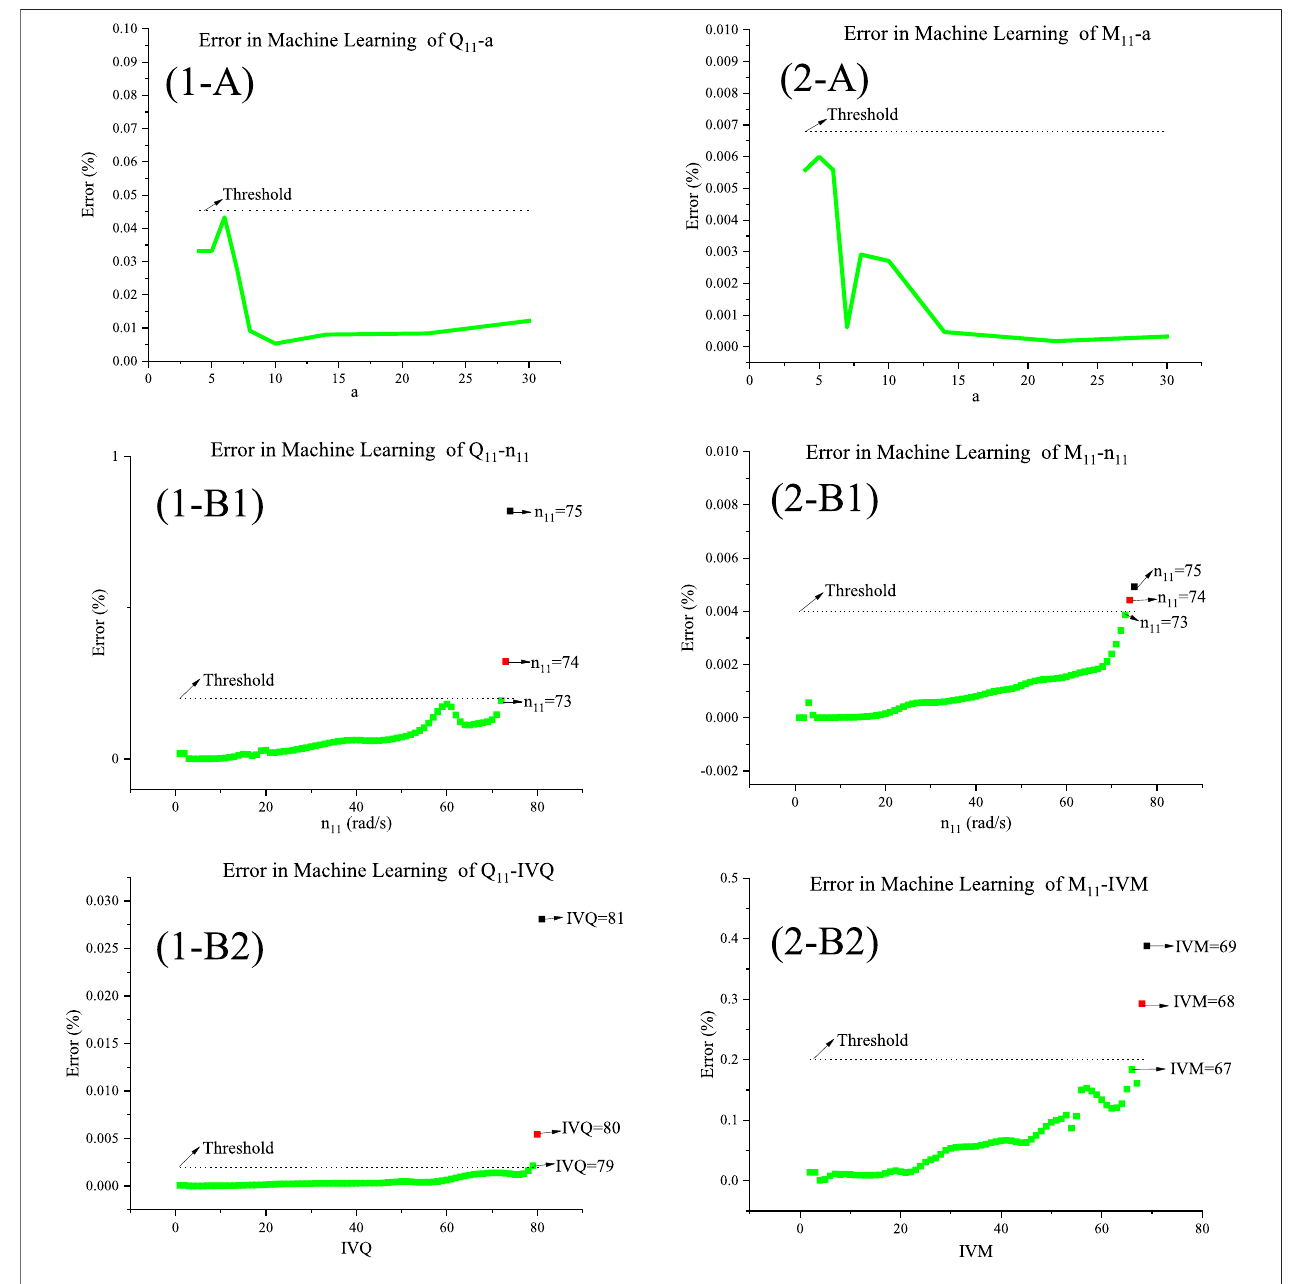
FIGURE 4 | ML error. (1-A) : Q 11 — a, (1-B1) : Q 11 — n 11 , (1-B2) : Q 11 — IVQ, (2-A) : M 11 — a, (2-B1) : M 11 — n 11 , and (2-B2) : M 11 — IVM.